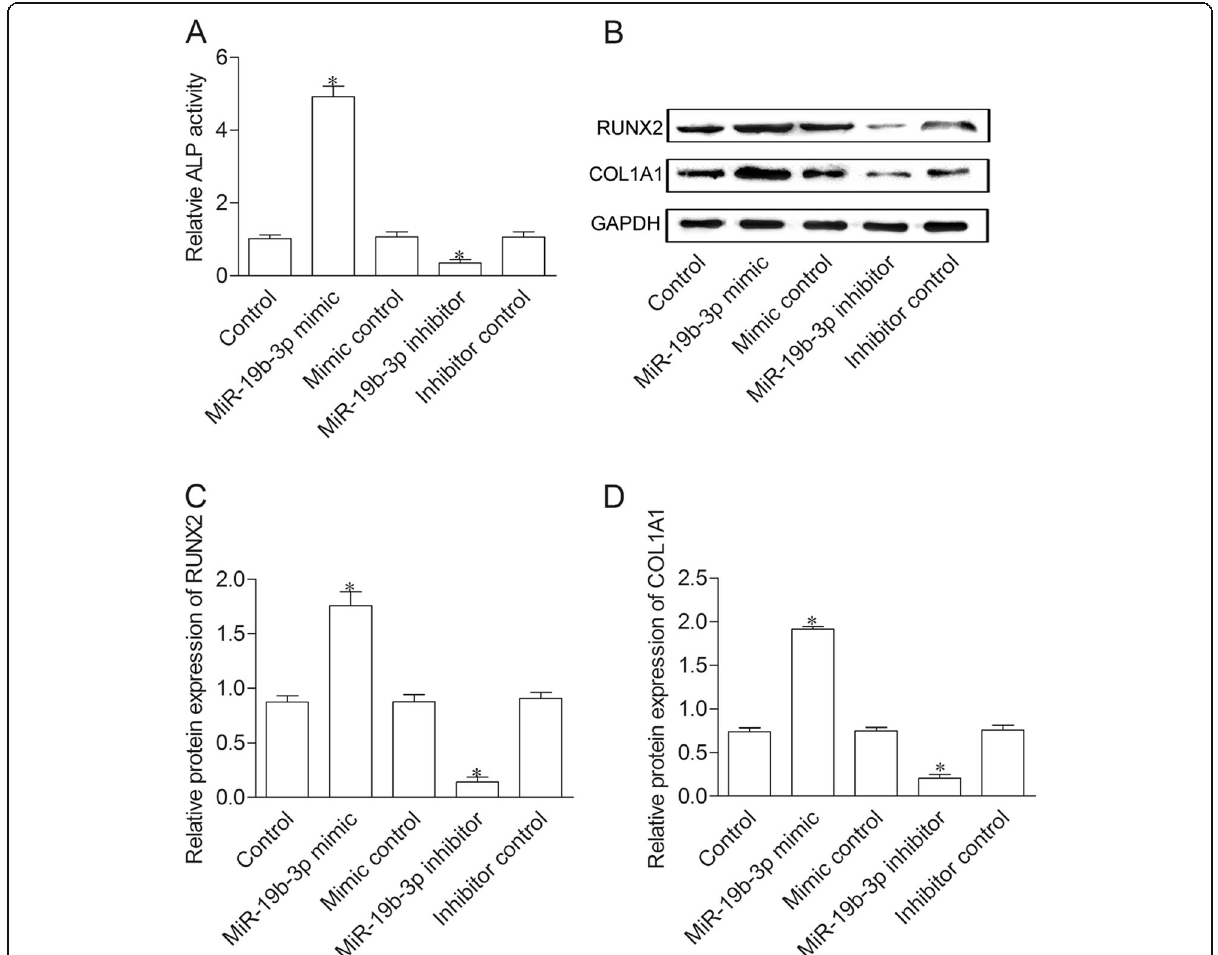
Fig. 3 MiR-19b-3p boost differentiation of BMSCs. ( a ) ALP activity was detected in the supernatant of cells. ( b ) Protein expression of RUNX2 and COL1A1 were measured by western blot method. ( c and d ) Relative protein level was normalized to GAPDH. * P < 0.05 versus healthy control